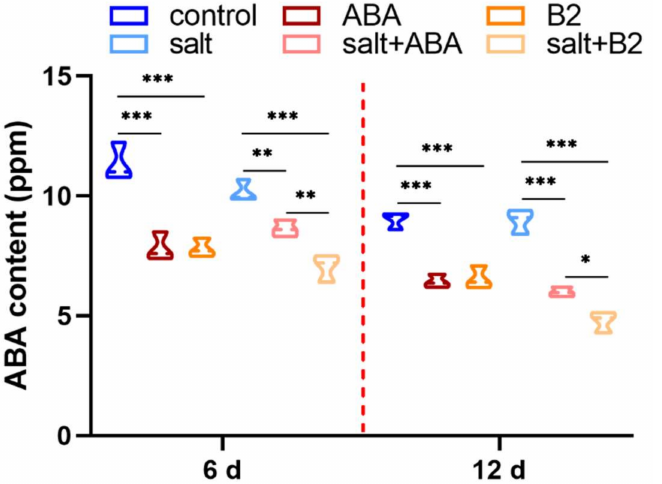
Figure 5. Content of endogenous ABA. ABA concentration was 100 µ M, and the concentration of B2 was 1.0 µ M (the functional effect of 1.0 µ M B2 was closer to ABA, and therefore we chose the concentration of B2 to be 1.0 µ M). The measurements were taken 6 days and 12 days after salt stress. Content (ppm) is indicated on the y -axis. Time is indicated on the x -axis. Values were found to be significantly different from controls by t -test at * p < 0.05, ** p ≤ 0.01, or *** p ≤ 0.001. Bars mean SD ( n =